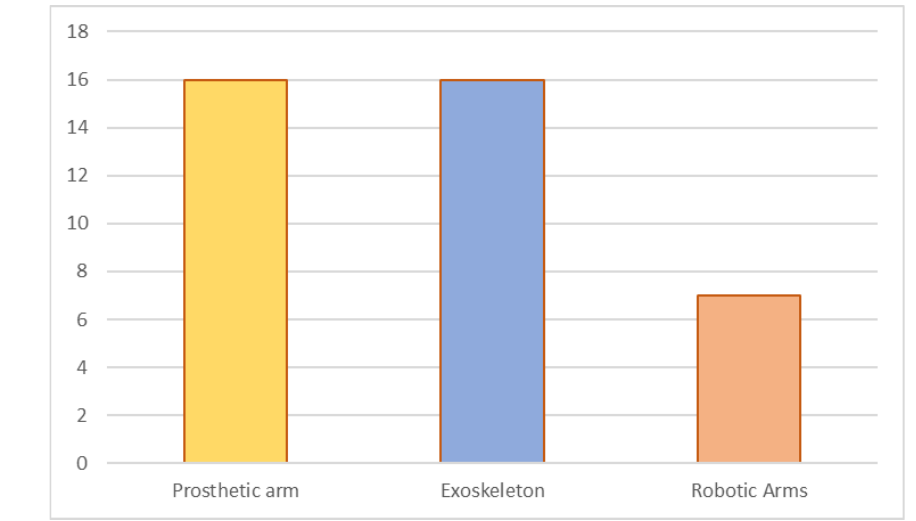
Figure 4 – Articles dealing with EEG